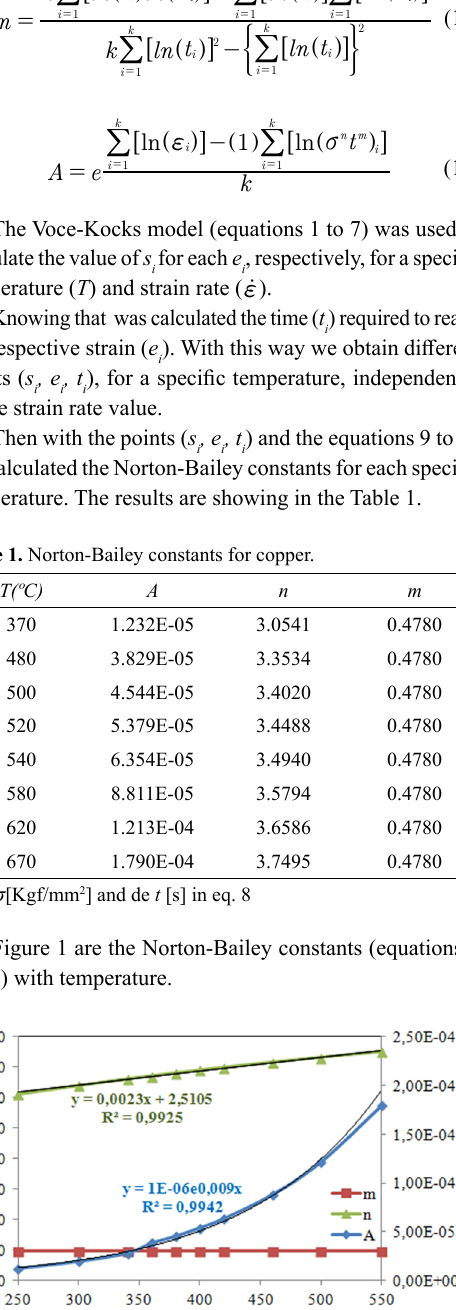
Figure 1. Norton-Bailey constants as a function of temperature for copper with strain rates between 0.1 and1 s -1 . Figure 2 is the behavior of the Norton-Bailey equation (equation 8) for copper at 520